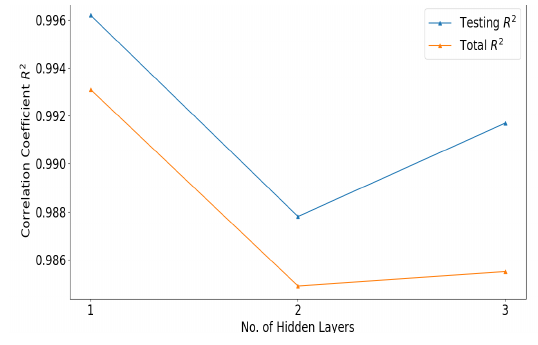
Figure 7. Comparison of R 2 values for different hidden layers for thrust force modelling